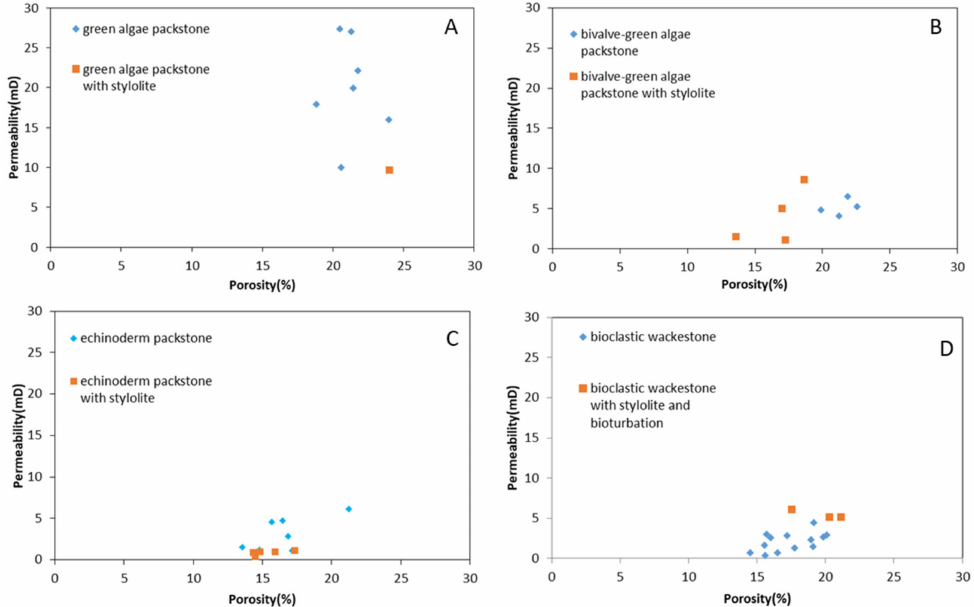
Figure 12. The cross-plot of porosity and permeability of limestones without or with stylolite in the Mi4 member: ( A ) green algae packstone; ( B ) bioclastic green algae packstone; ( C ) echinoderm packstone; ( D ) bioclastic